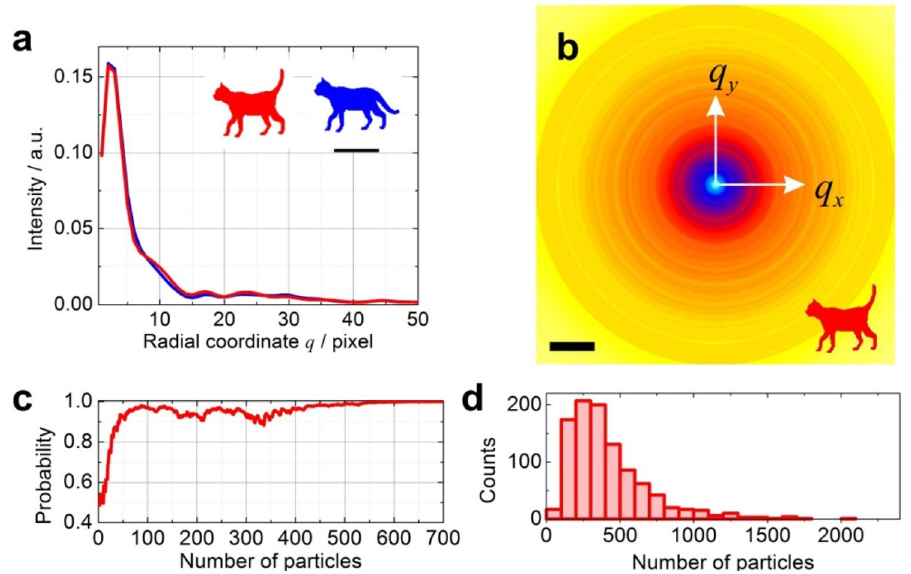
Figure 3. Principle of structure determination demonstrated for a binary sample – a cat cartoon. ( a ) The sample can be found in two conformations: with tail up ("up", shown in red) or tail down ("down", shown in blue). ( a ) 1D PDF profiles corresponding to the diffraction patterns; the region where two signals exhibit difference is shown. The scalebar is 60 a.u. ( b ) Azimuthally-averaged diffraction pattern of "up" conformation. The scalebar is 5 pixels in the Fourier space, with 1 pixel = 1/400 a.u. ( c ) Probability of the right hypothesis ("up") as a function of the number of detected scattered particles. ( d ) Number of particles required to achieve 95% probability that the sample structure hypothesis is correct; results of 1000 experiments are